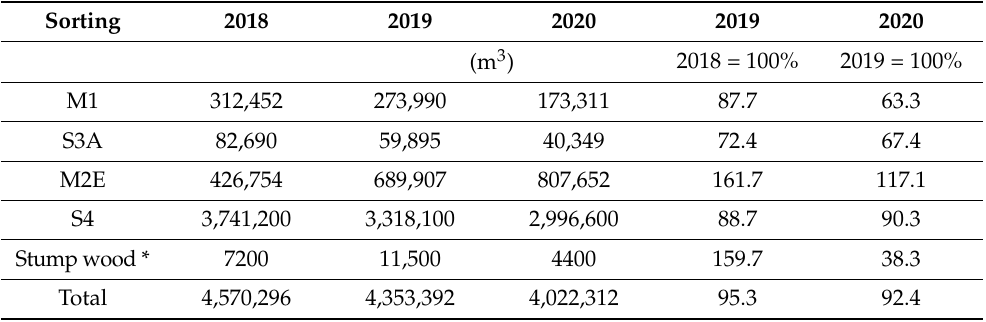
Table 2. The volume and dynamics of wood harvested in forests for chipping (based on: Statistical Yearbook of Forestry 2019–2021 [30,31]).